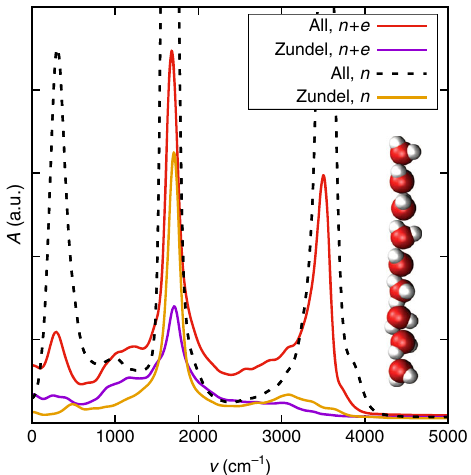
Fig. 3 Spectral decomposition for a protonated chain. Comparison of the simulated infrared spectrum of the protonated narrow chain in the axial direction including electronic degrees of freedom ( n + e , red line) to the spectrum obtained from nuclei only by assigning effective charges q H = − q = 1 e ( n , broken line), the spectrum of the projected Zundel ensemble O /2 including electronic degrees of freedom (violet line), and the spectrum calculated from the Zundel ensemble using nuclei only (yellow